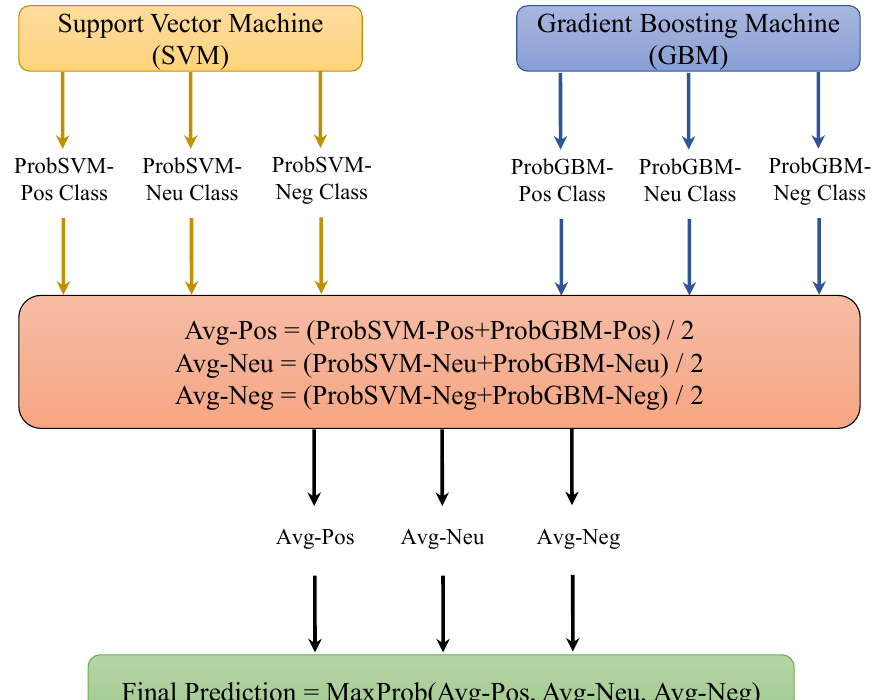
Figure 5. Architecture of the proposed voting Classifier (GBSVM). ProbSVM-Pos represents SVM given probability score for a specific class while ProbGBM-Pos is for the GBM score of a particular class.